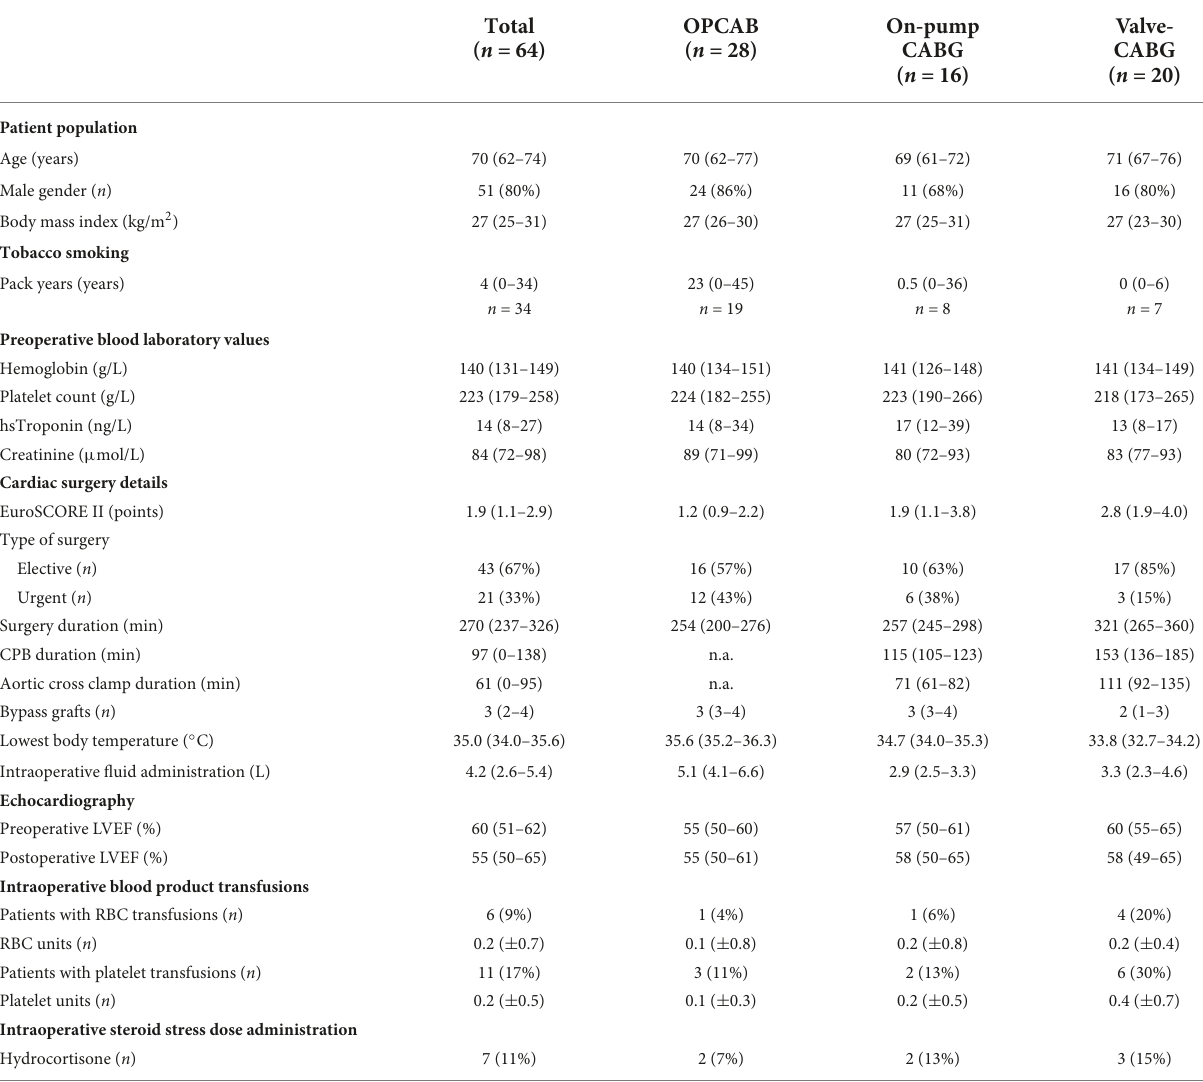
TABLE 1 Patient characteristics and details of cardiac